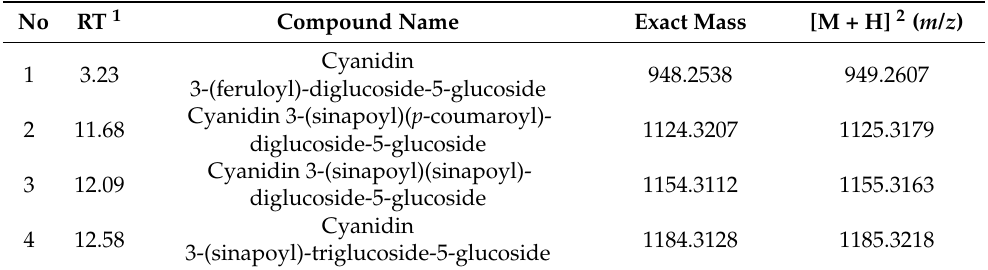
Figure 7. Representative HPLC chromatogram from 50× CFS-treated kale monitored at 520 nm. Peak 1, cyanidin 3-(feruloyl)-diglucoside-5-glucoside; 2, cyanidin 3-(sinapoly)( p -coumaroyl)-diglucoside-5-glucoside; 3, cyanidin 3-(sinapolyl)(sinapoyl)-diglucoside-5-glucoside; and 4, cyanidin 3-(sinapoyl)-triglucoside-5-glucoside. Table 4. Anthocyanins identified in “Red Russian” kale.